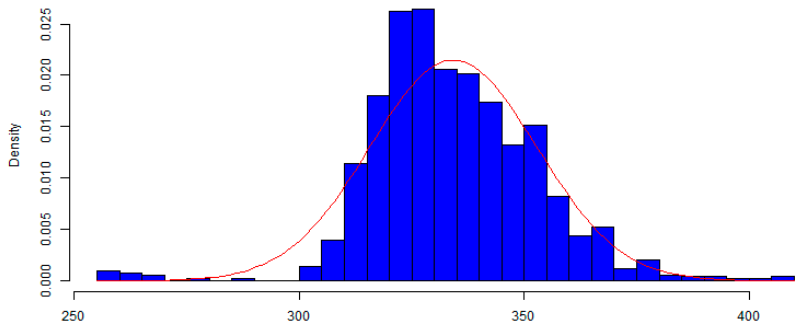
Figure 2. Monte Carlo simulation - price.